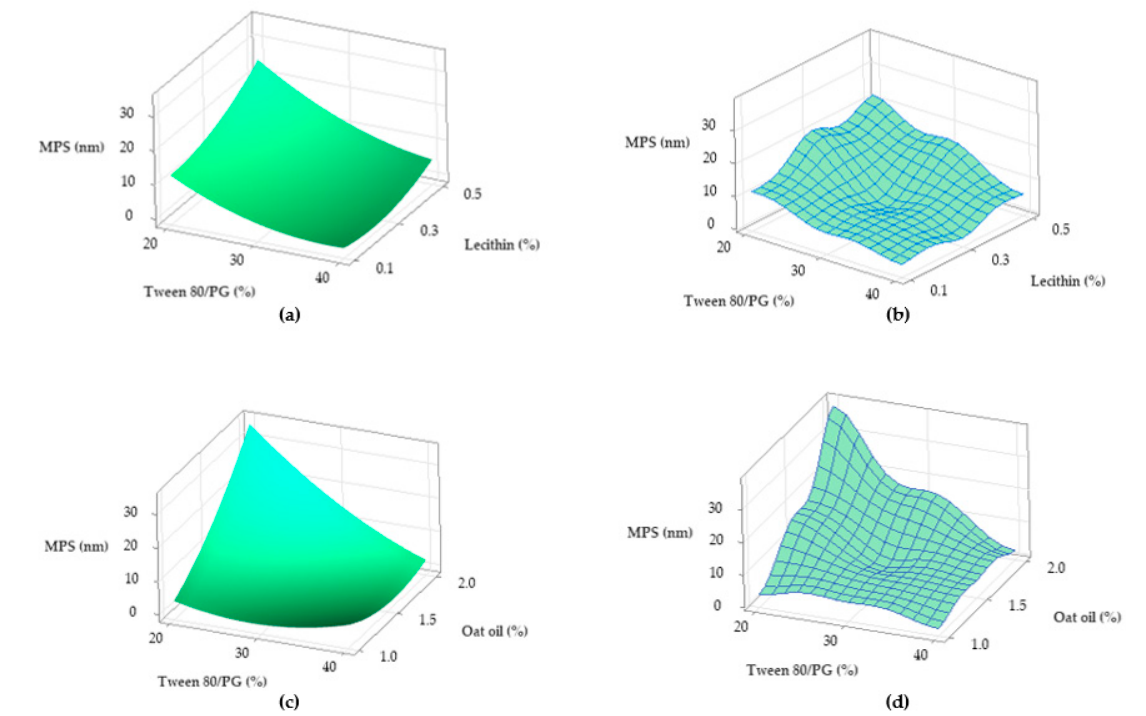
Figure 18. Surface plots representing: Ds response (Y 2 ) as a function of Tween 80/PG (%) and lecithin (%) in two cases—( a ) Surface representation in gradient color; ( b ) Wireframe model, and Ds response (Y 2 ) as function of Tween 80/PG (%) and Oat oil (%) in two cases—( c ) Surface representation in gradient color; ( d ) Wireframe model.